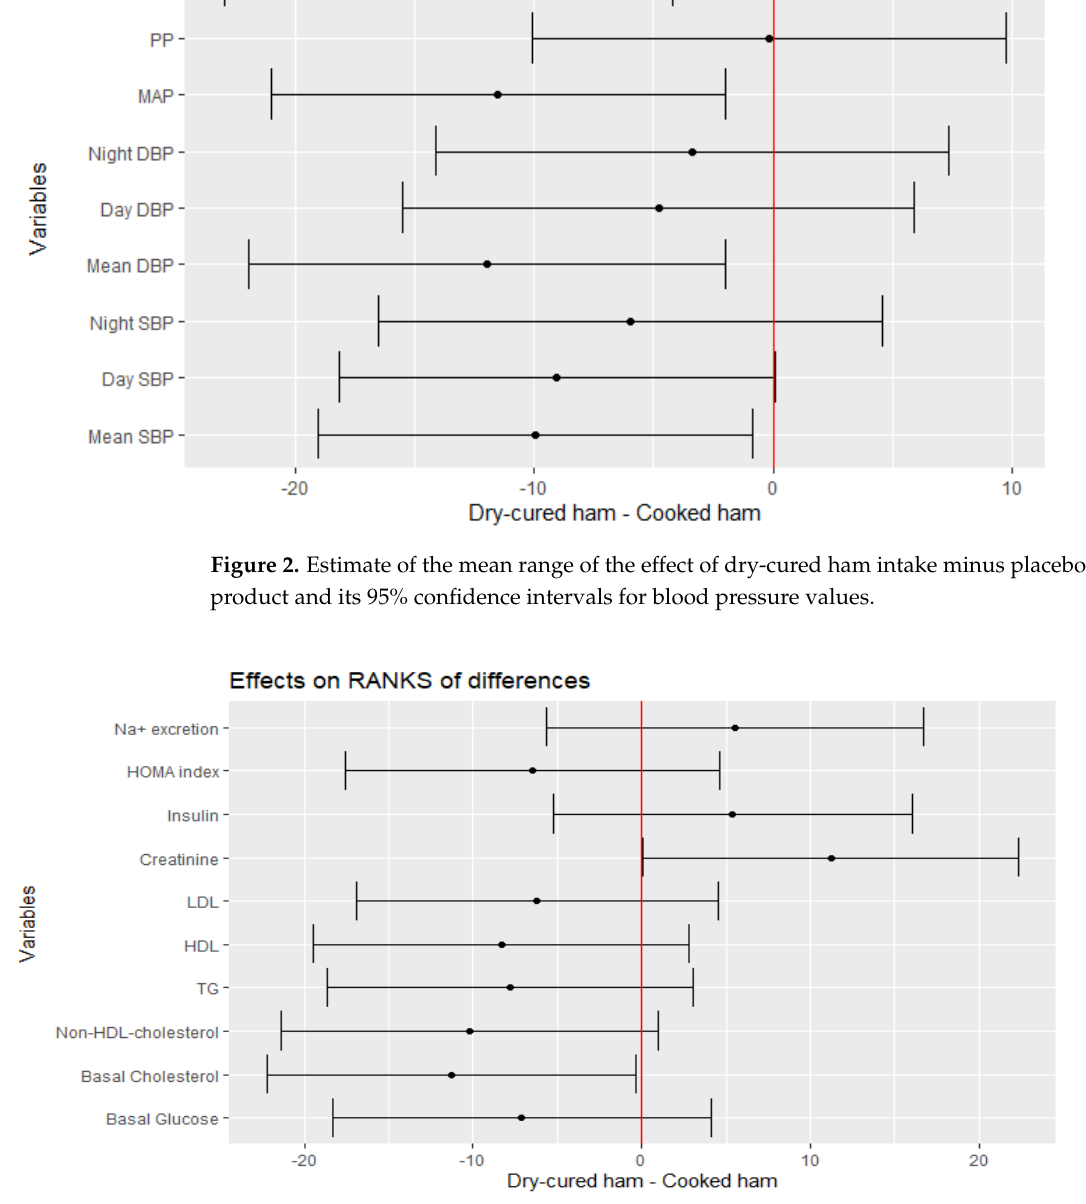
Figure 3. Estimate of the mean range of the effect of dry-cured ham intake minus placebo product and its 95% confidence intervals for hematological and clinical parameters.